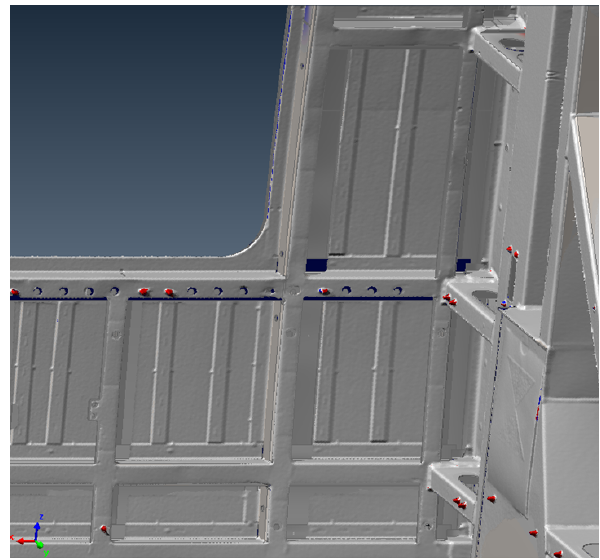
Figure 8. Sidewall section. Presentation of the 3D data set, the colour marking encodes the distance of the corresponding points of the point cloud (software,